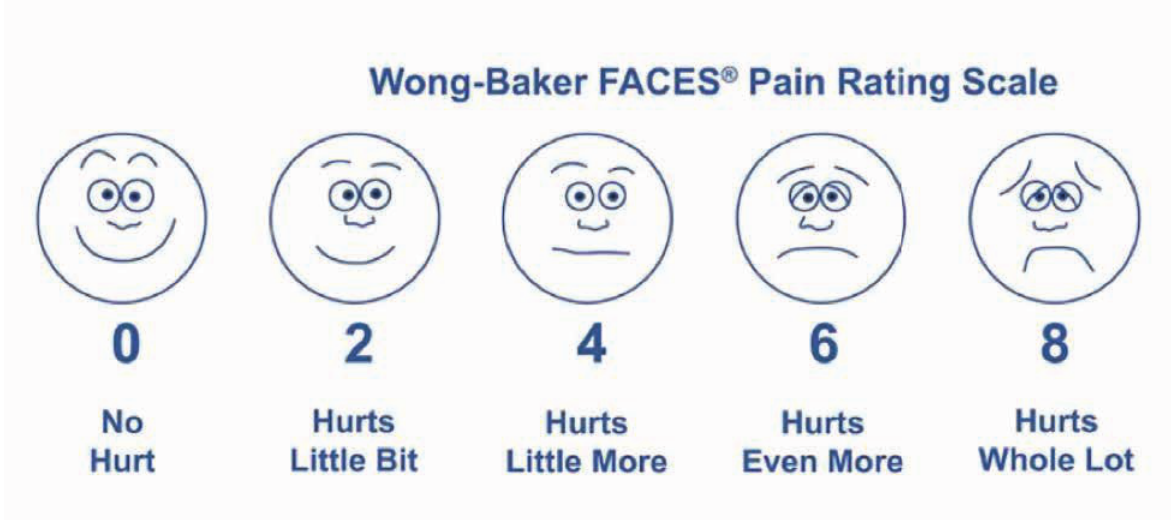
Figure 2: Wong-Baker scale for pain